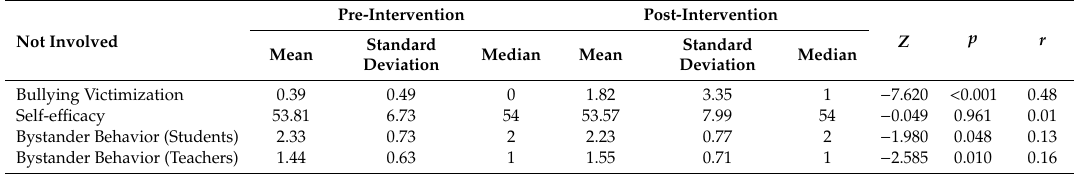
Table 1. Bullying victimization, self-e ffi cacy and the perceived bystanders’ behavior of the not involved students.